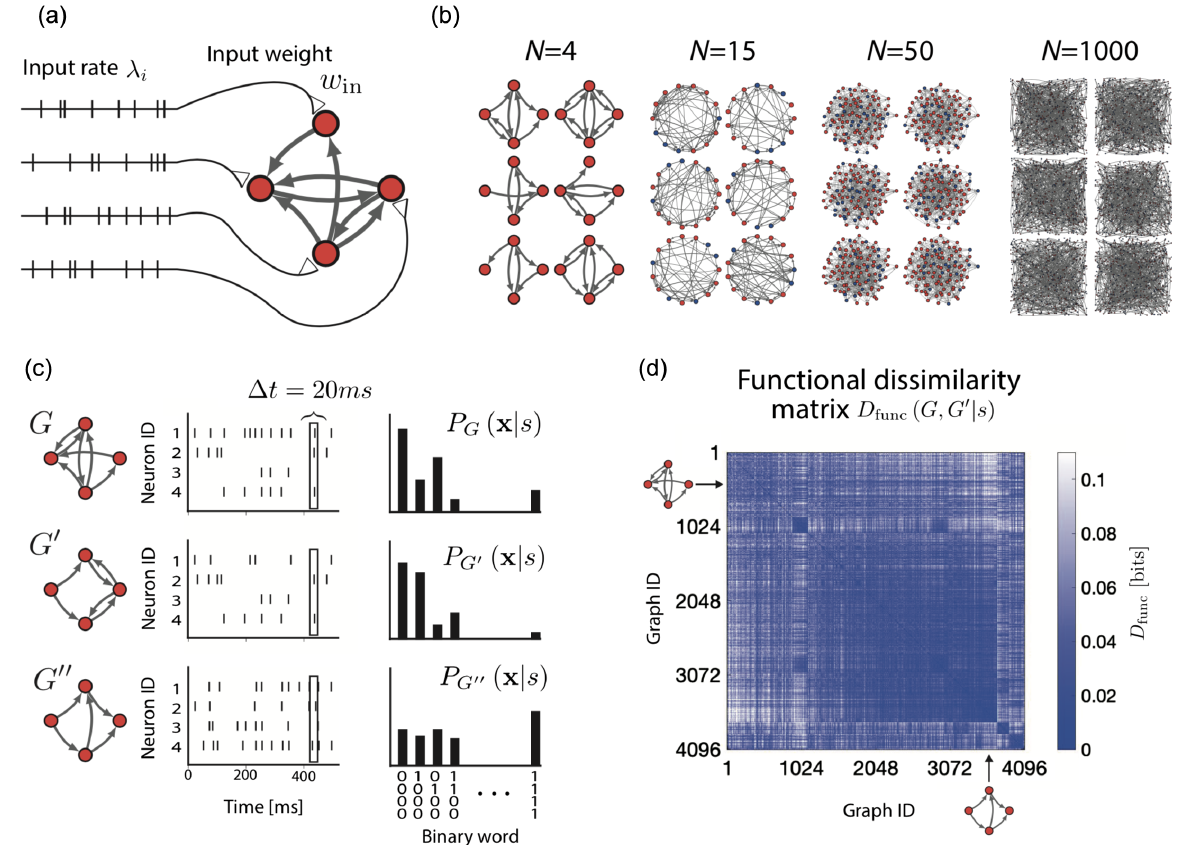
FIG. 1. Simulating the responses of ensembles of networks to the same stimuli and computing functional similarity between networks. (a) Each of the N neurons in the simulated networks receive as an input a Poisson spike train with rate λ ; corresponding neurons in all i networks in the ensemble receive the same exact i th spike train as input. (b) Examples of the simulated networks: networks of four neurons with identical excitatory synapses and networks of 15, 50, or 1000 excitatory and inhibitory neurons where the synaptic weights are drawn from a log-normal distribution. (c) Examples of segments of the spike train responses of different networks (left) that are presented with the same stimulus. The activity of the neurons is discretized into bins of length Δ t ¼ 20 ms and binarized (middle; see the text). The different responses of the networks result in different distributions of population activity patterns (right). (d) The functional G; G 0 j s Þ for networks of size N ¼ 4 . The normalized stimulus strength is η ¼ 1 . 5 (see Sec. IV), which results dissimilarity matrix D func ð in firing rates ranging between 10 and 20 Hz over all networks in the ensemble. The structure of this matrix implies a low-dimension organization of the functional space of networks (see the